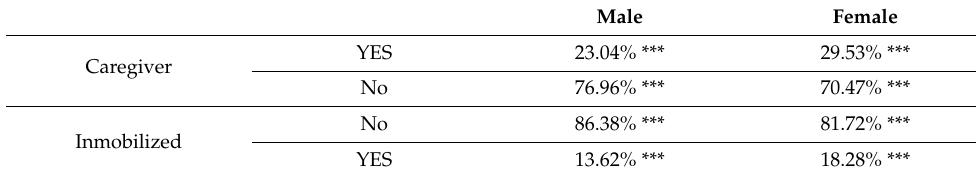
Table 9. Living situation and immobilization of persons over 65 years of age living alone according to sex. Basic Health Areas of Gran Canaria. 2018–2020. (Percentages—%). Male Female YES 23.04% *** Caregiver Inmobilized